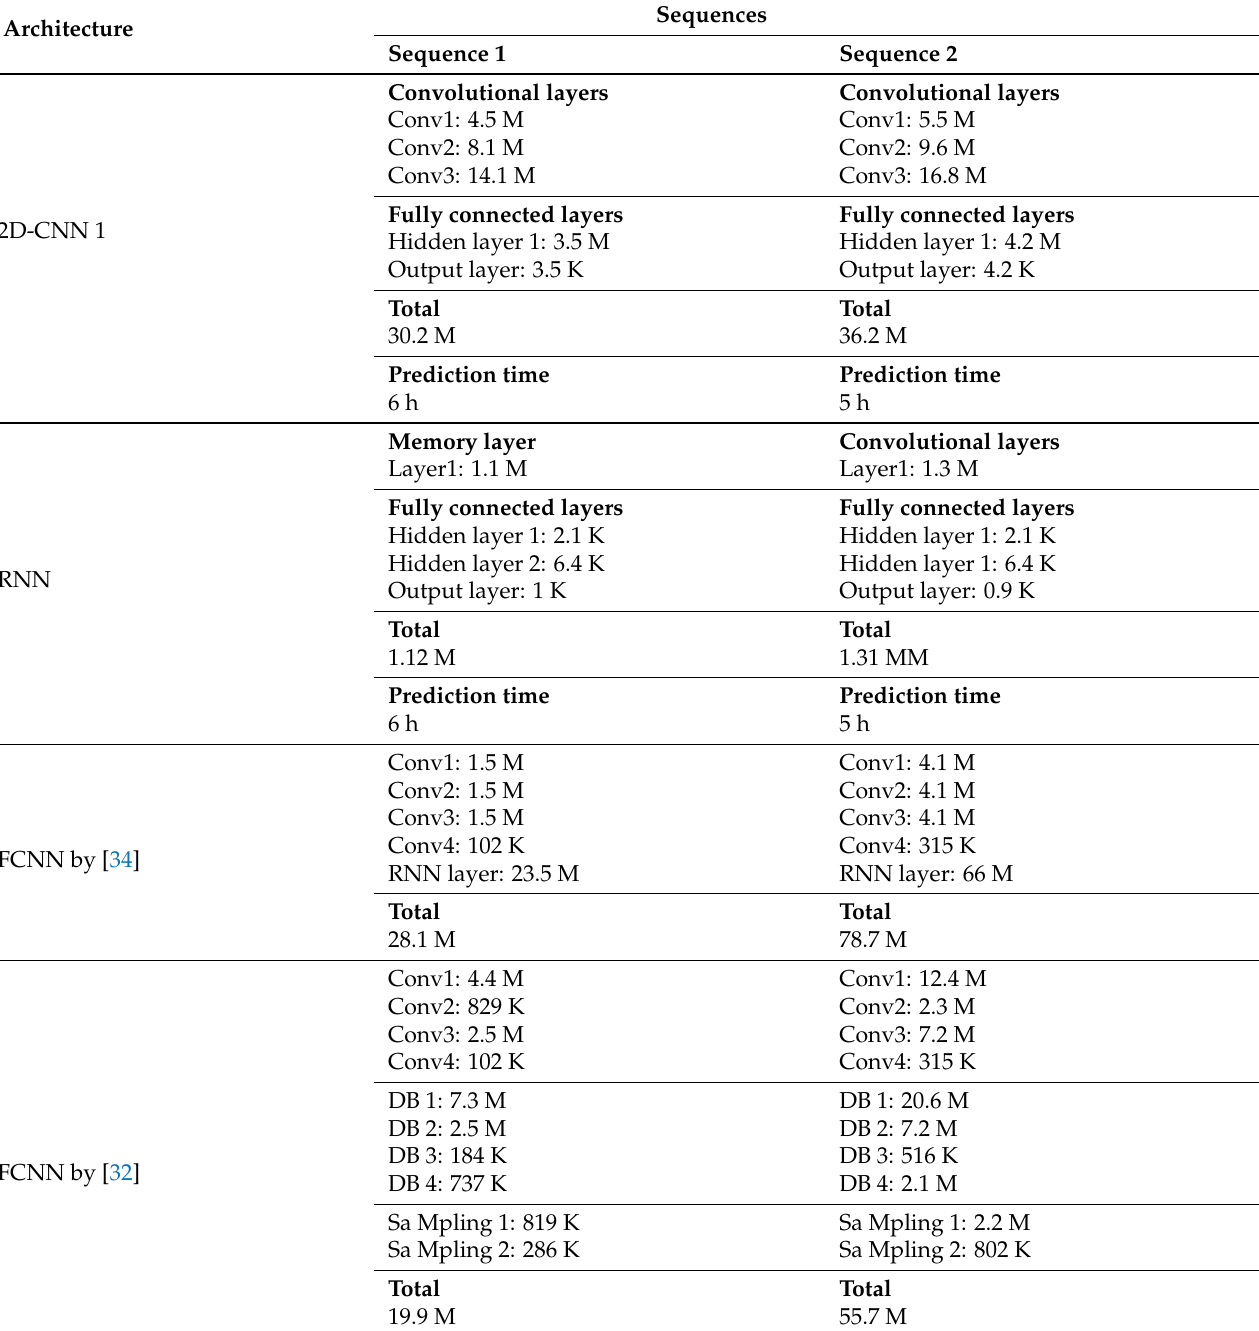
Table 7. Computational complexity of the compared DL